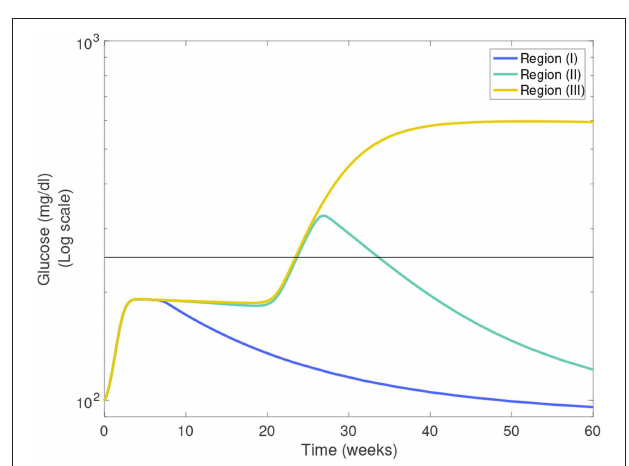
FIGURE 8 | Representative glucose levels for the three clearance regions from Figure 7B : (I) non-diabetic, (II) non-diabetic after hyperglycemia, and (III)